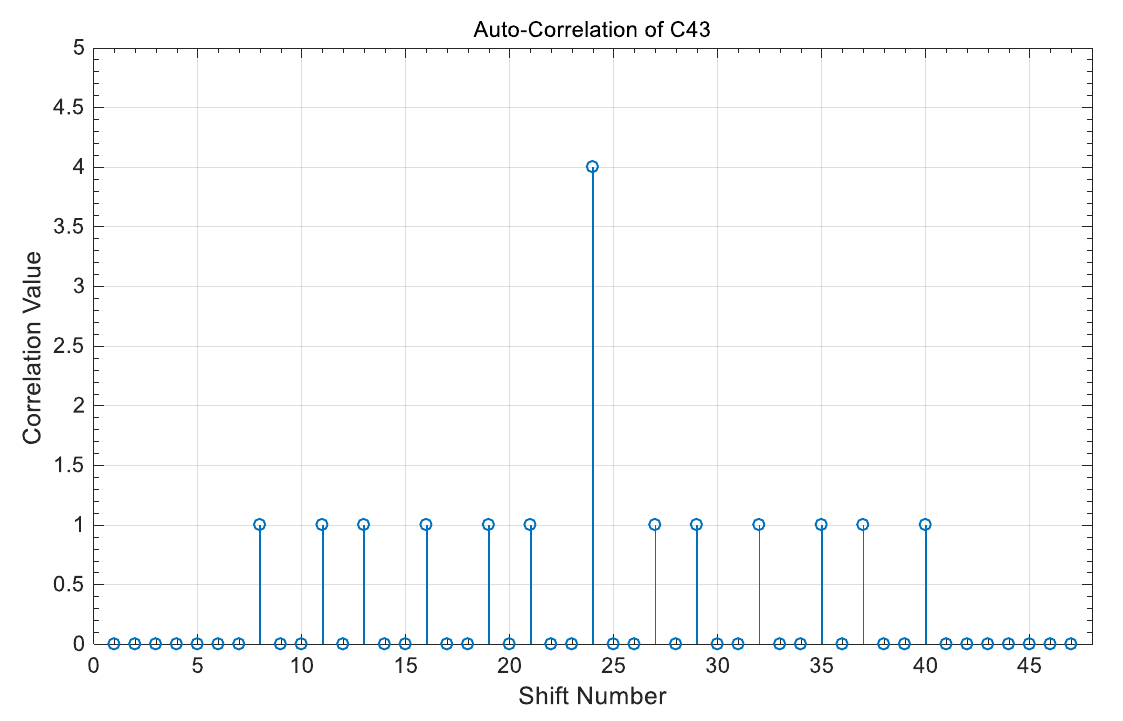
Figure 2. Auto-correlation of 𝐶 43 sequence, 𝑃 1 = 5 and 𝑃 2 = 7 .